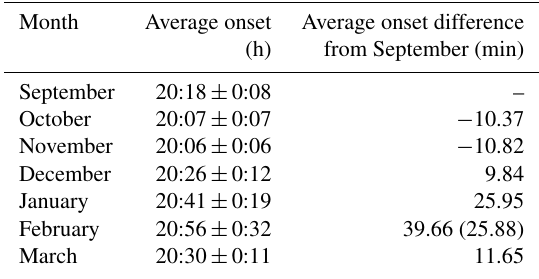
Table 1. Averaged scintillation onset time for Cachoeira Paulista and the time difference, taking as reference the September onset